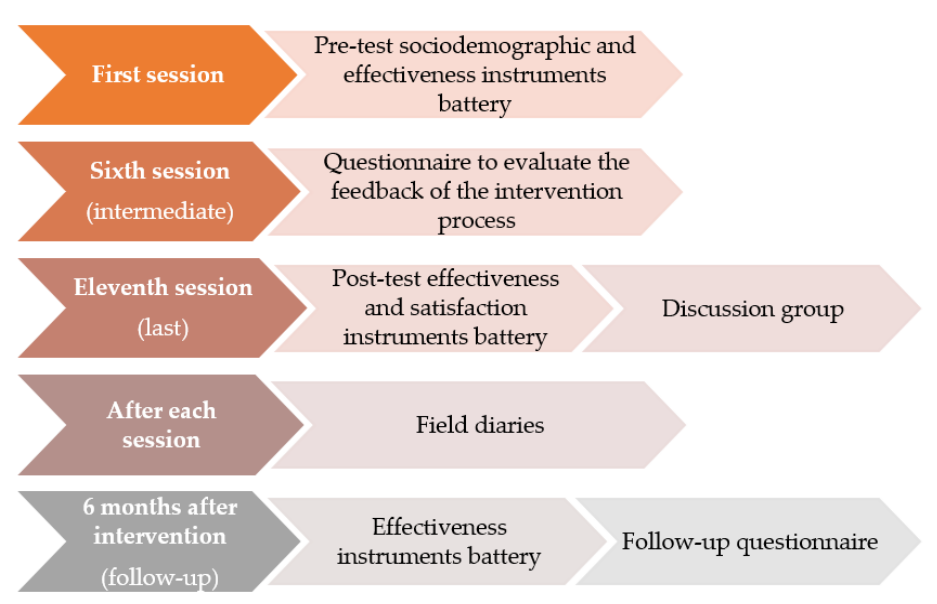
Figure 1. Evaluation process of the MBSR-P intervention program.